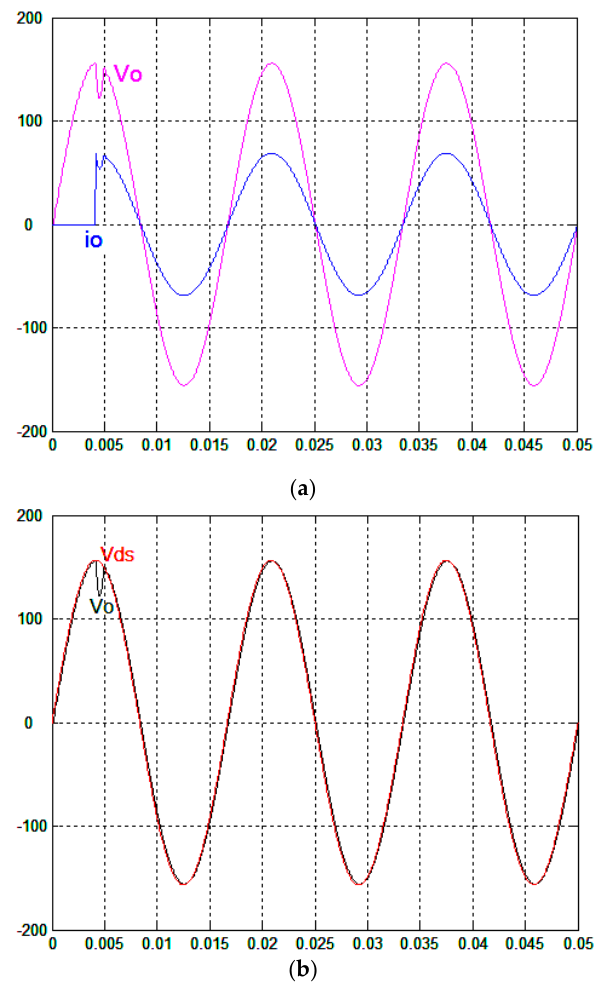
Figure 3. ( a ) Simulation waveforms of the output voltage and output current under step load change for the classical finite ‐ time convergent SMGL (100 V/div; 20 A/div); ( b ) Trajectories of output voltage and reference sine wave.